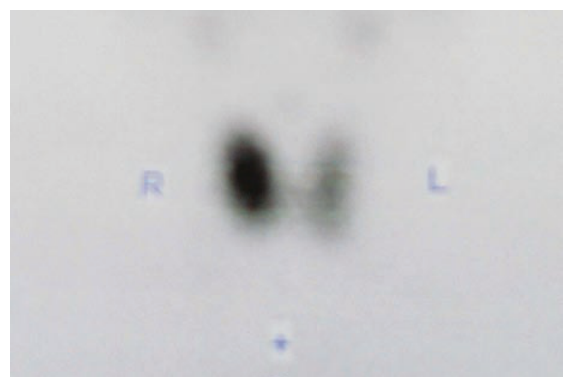
Figure 2. Blood smear.